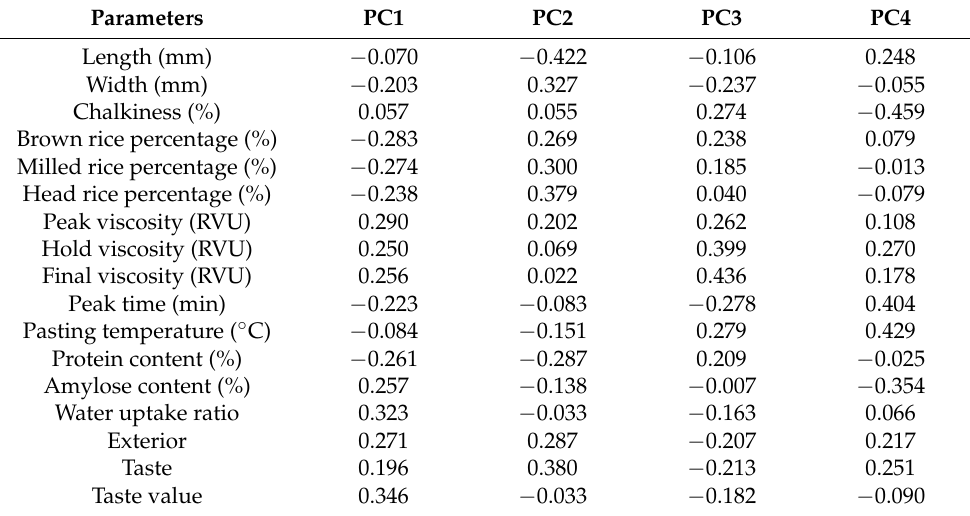
Table 2. Eigenvectors of corresponding matrices for rice quality traits.